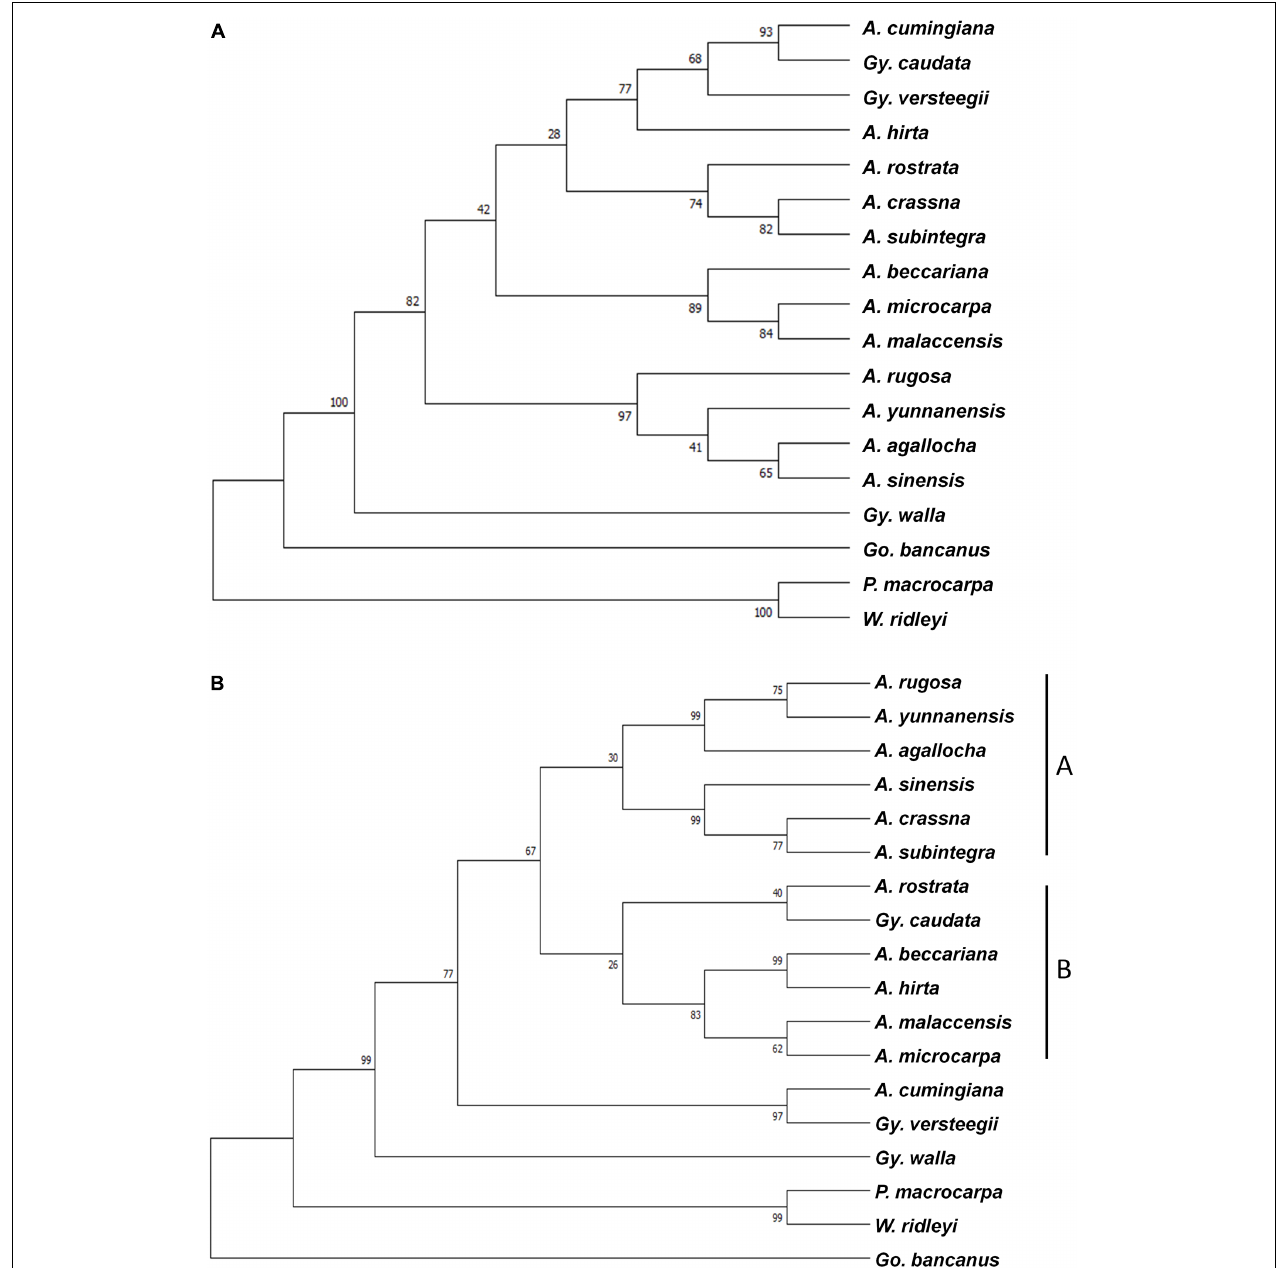
FIGURE 2 | Maximum likelihood tree of 15 species from the Aquilarieae tribe based on (A) a combined data set of five chloroplast loci ( mat K, rbc L, trn L intron, trn L- trn F, and psb C- trn S), and (B) the nuclear region DNA internal transcribed spacer (ITS) region. Gonystylus bancanus , Phaleria macrocarpa , and Wikstroemia ridleyi served as outgroups. Bootstrap values for a majority of divergences are > 50%, as indicated on the corresponding nodes.